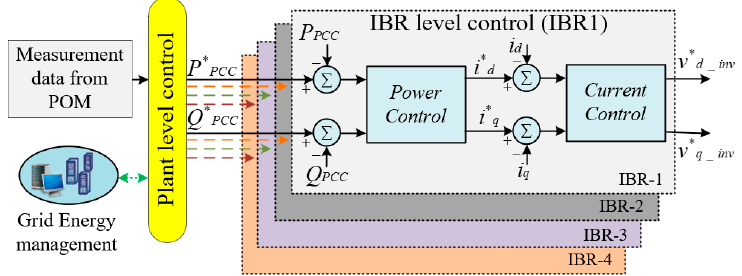
Figure 2. Plant level and IBR level controller structure of an inverter interfaced IBR plant.